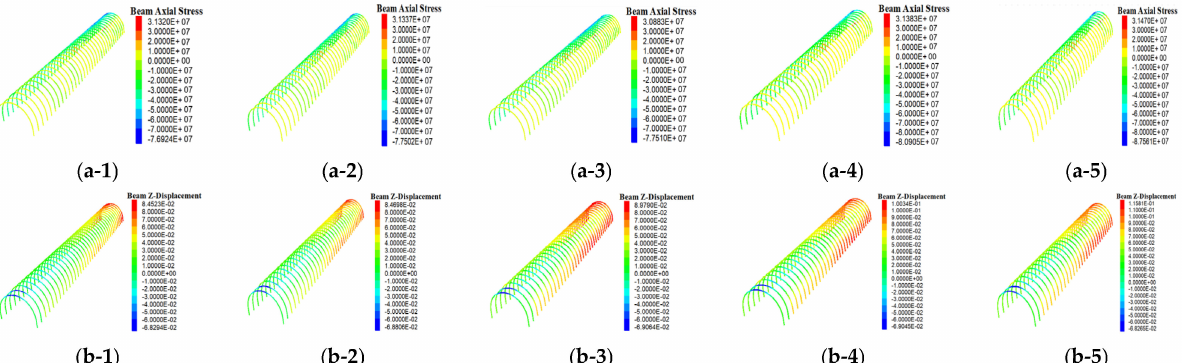
Figure 11. Nephograms of axial stress and vertical displacement of a U-steel section under different URDs. ( a-1 ) Axial stress of a U-steel section at 2 m behind the heading face. ( a-2 ) Axial stress of a U-steel section at 4 m behind the heading face. ( a-3 ) Axial stress of a U-steel section at 6 m behind the heading face. ( a-4 ) Axial stress of a U-steel section at 8 m behind the heading face. ( a-5 ) Axial stress of a U-steel section at 10 m behind the heading face. ( b-1 ) Vertical displacement of a U-steel section at 2 m behind the heading face. ( b-2 ) Vertical displacement of a U-steel section at 4 m behind the heading face. ( b-3 ) Vertical displacement of a U-steel section at 6 m behind the heading face. ( b-4 ) Vertical displacement of a U-steel section at 8 m behind the heading face. ( b-5 ) Vertical displacement of a